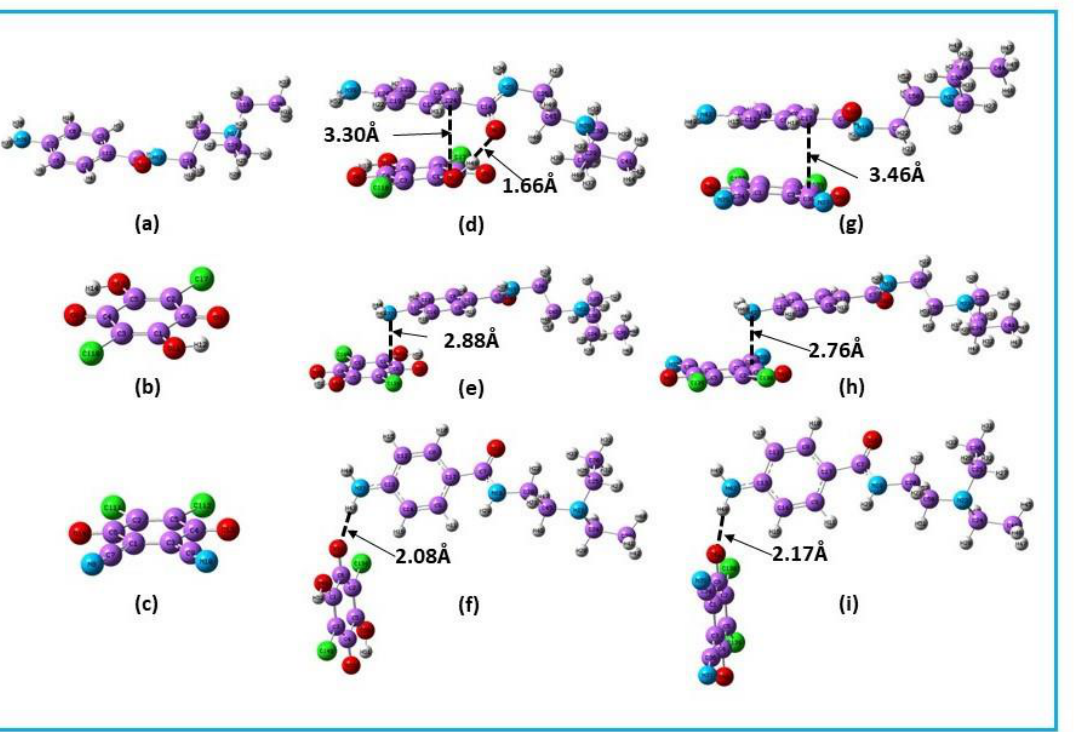
Figure 11. Optimized structures of PA, ChA, DDQ, and their complexes: ( a ) PA; ( b ) ChA; ( c ) DDQ; ( d ) face-to-face I fashion complex of PA with ChA; ( e ) face-to-face II fashion complex of PA complex with ChA; ( f ) edge-to-edge fashion complex of PA with ChA; ( g ) face-to-face I fashion complex of PA with DDQ; ( h ) face-to-face II fashion complex of PA complex with DDQ; and ( i ) edge-to-edge fashion complex of PA with DDQ at the ω B97XD/6-311++G(2d,p) level of theory in acetonitrile solvent system. Close nonbonded contact distances are highlighted in Å.